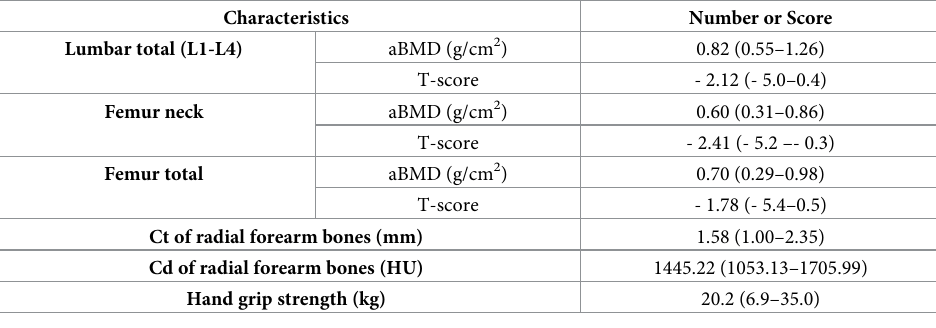
Table 2. Clinical parameters and the bone properties of the participants.